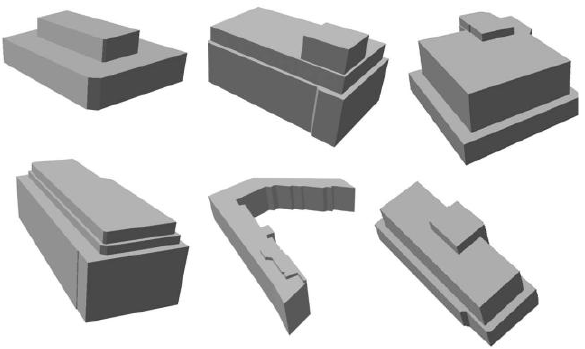
Figure 10. Reconstructed office buildings.